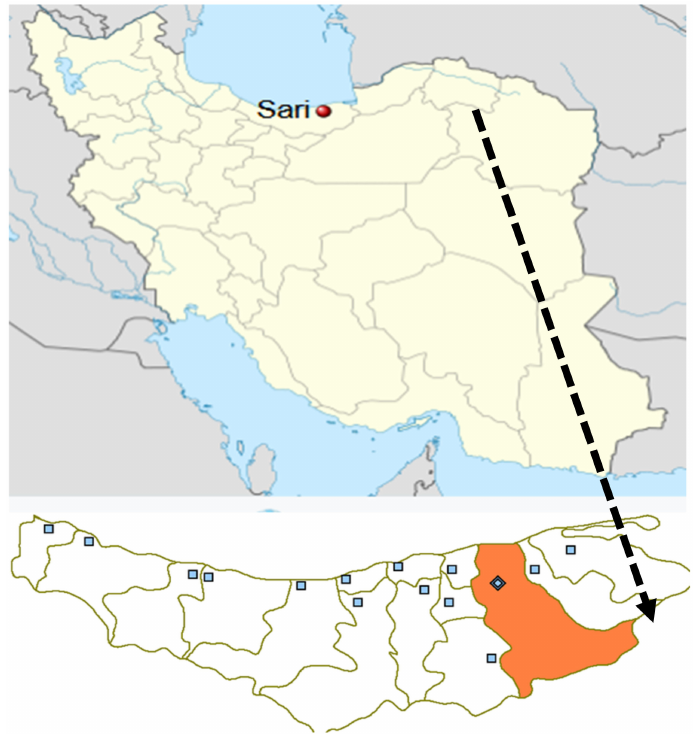
Figure 2. Geographical location of the study area (Sari is the capital of Mazandaran Province located in Northern